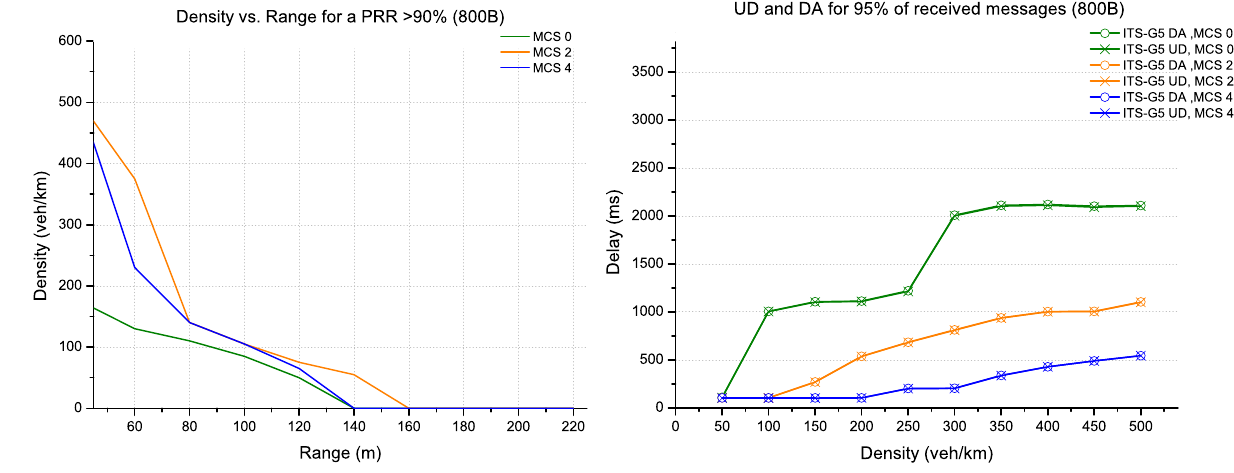
Figure 5. Evaluation for ITS-G5 technology (packet size 800 bytes).